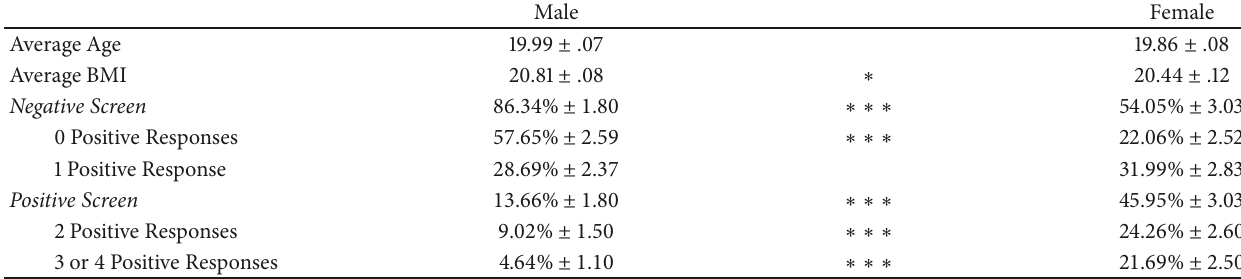
Table 2: Screening rates for Eating Disorders in NCAA Division I male and female cross country and track student-athletes using the Eating Disorder Screen for Primary Care